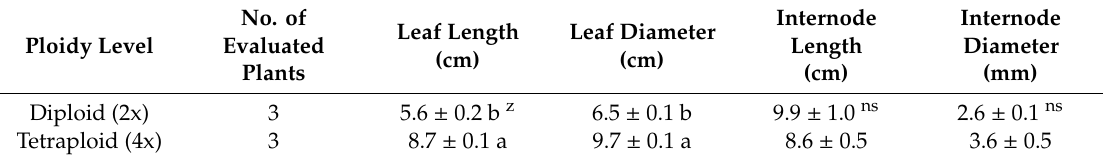
Table 3. Comparison of the morphological characteristics of colchicine-treated pointed gourd seedlings with di ff erent ploidy levels.